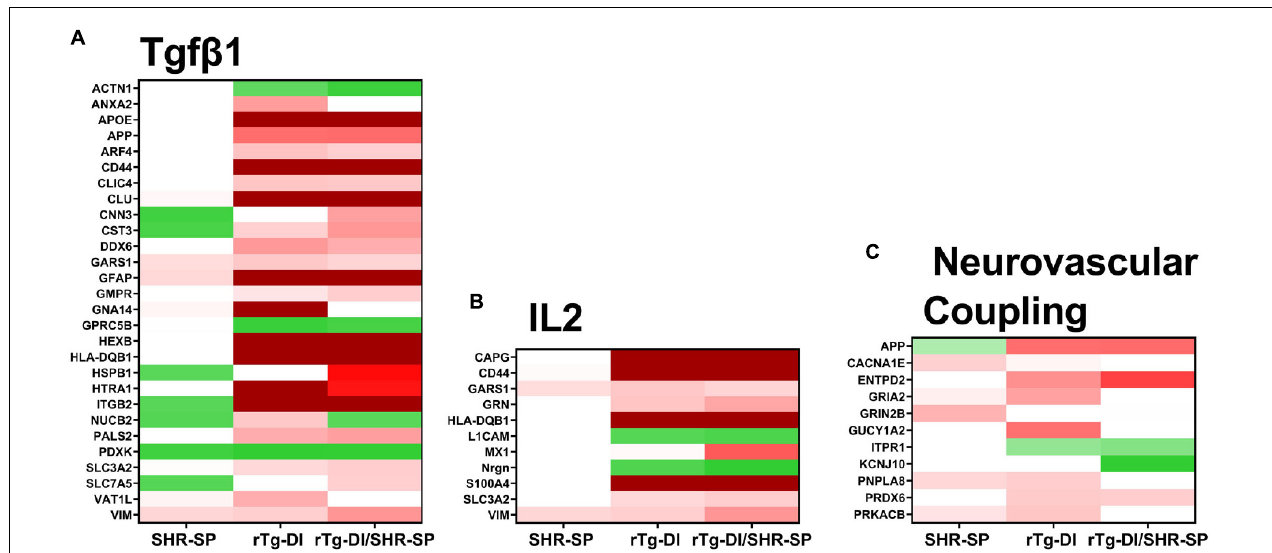
FIGURE 12 | IPA identified upstream regulators, causal networks, and disease functions. (A) Heat map depicting the differentially expressed proteins ( ≥ 50% increase or ≥ 30% decrease, P < 0.05) in the SHR-SP, rTg-DI, and bigenic rTg-DI/SHR-SP cortex associated with the upstream regulator Tgf β 1 (A) , Interleukin 2 causal network (B) and the pathway neurovascular coupling (C) . Red indicates increased, green indicates decreased, and white indicates not differentially expressed proteins, and color intensity correlates with degree of